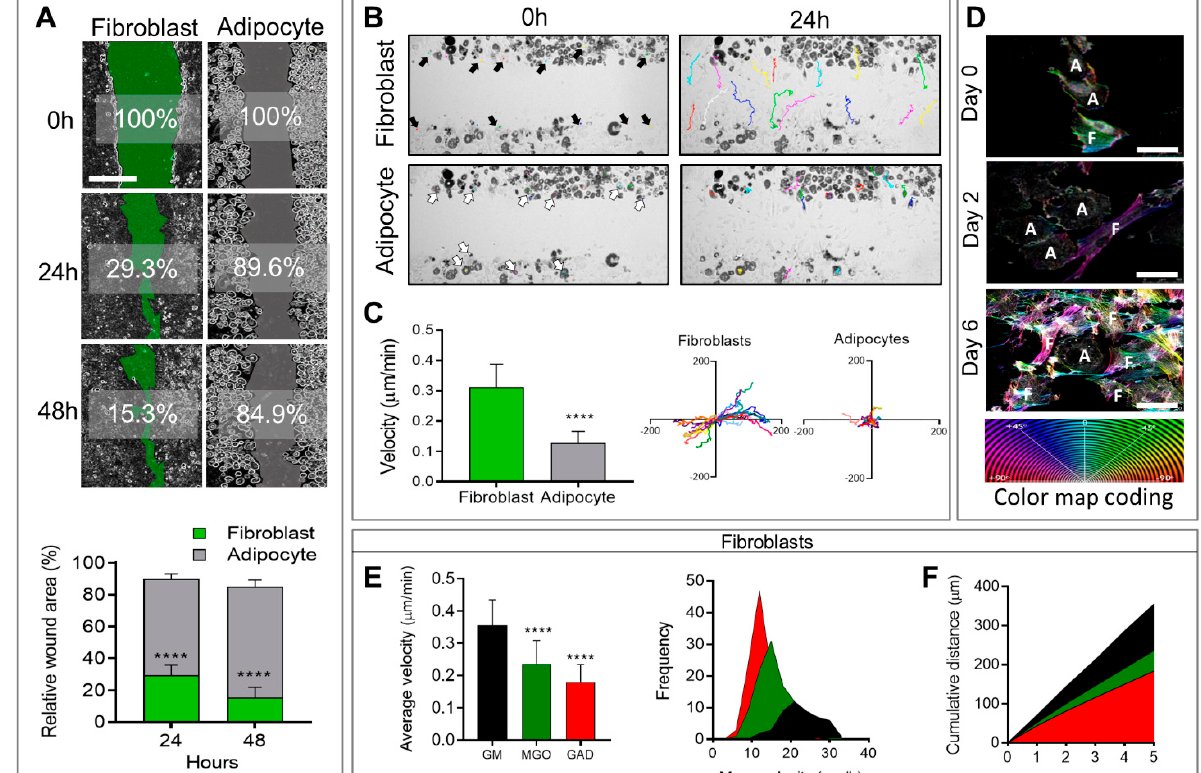
Figure 3. Wound healing and cell motility follow-up on live imaging. ( A ) Wound healing assay of fibroblast (green) and adipocytes (grey) follow-up over 48 h for % of wound area remaining to be closed (scale bar = 650 µm) (upper panel). The relative wound area for fibroblasts (n = 14) and adipocytes (n = 8) was quantified after 24 h and 48 h (lower panel). ( B ) Phase-contrast images; fibroblasts (black arrows, multicolor lines), and adipocytes (white arrows, multicolor dots) follow distance after 24 h. ( C ) Single-cell velocity of fibroblasts (n = 20) and adipocytes (n = 20) represented by a µm/min for over 24 h (left). Single-cell migration representation of a trajectory plot evaluating the accumulating distance, normalized to a common starting point (right). ( D ) The high-resolution images on days 0 to 6 illustrate the association between actin reorganization and cell motility (F–fibroblast, A–adipocyte) by a color map of HSB status (scale bar = 50 µm). The effect of hyperglycemic conditions on cell motility: ( E ) Average velocity quantification of individual cells was measured in untreated fibroblasts (n = 49, black), MGO (n = 98, green), and GAD (n = 106, red) treated cells (left). Frequency distribution of mean velocity range in treated groups (right). ( F ) Cumulative distance quantification displays the total cell’s distance over 5 h. Two-way ANOVA used for ( A ), Student’s unpaired t-test for ( C ), one-way ANOVA with Sidak’s multiple comparisons test ( B ), and Games–Howell multiple comparisons test ( D ); average velocity (mean ± SD). (**** p < 0.0001)